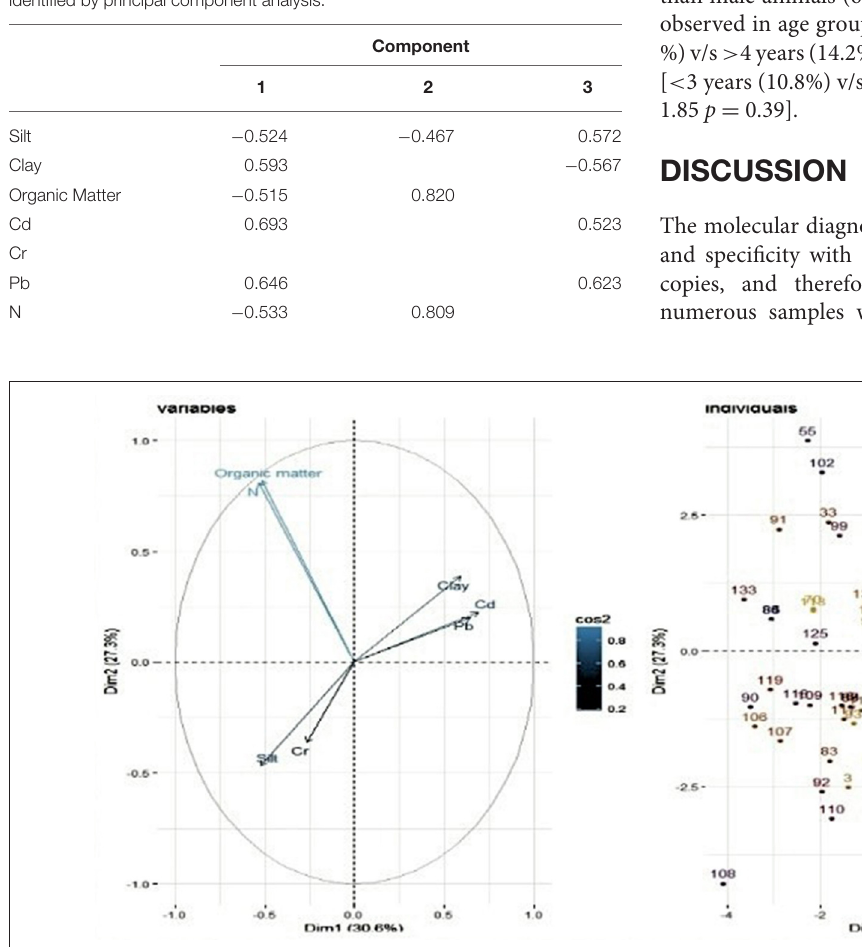
TABLE 2 | Factor-loading matrix for the phyio-chemical attributes of soil sampled identified by principal component analysis.